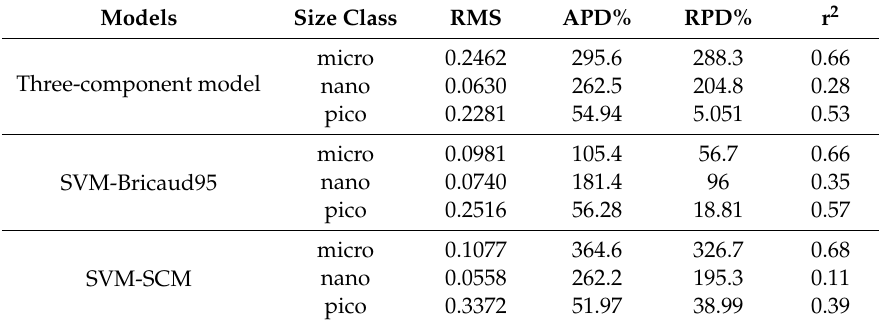
Table 3. Statistics of the three models used to retrieve PSC.